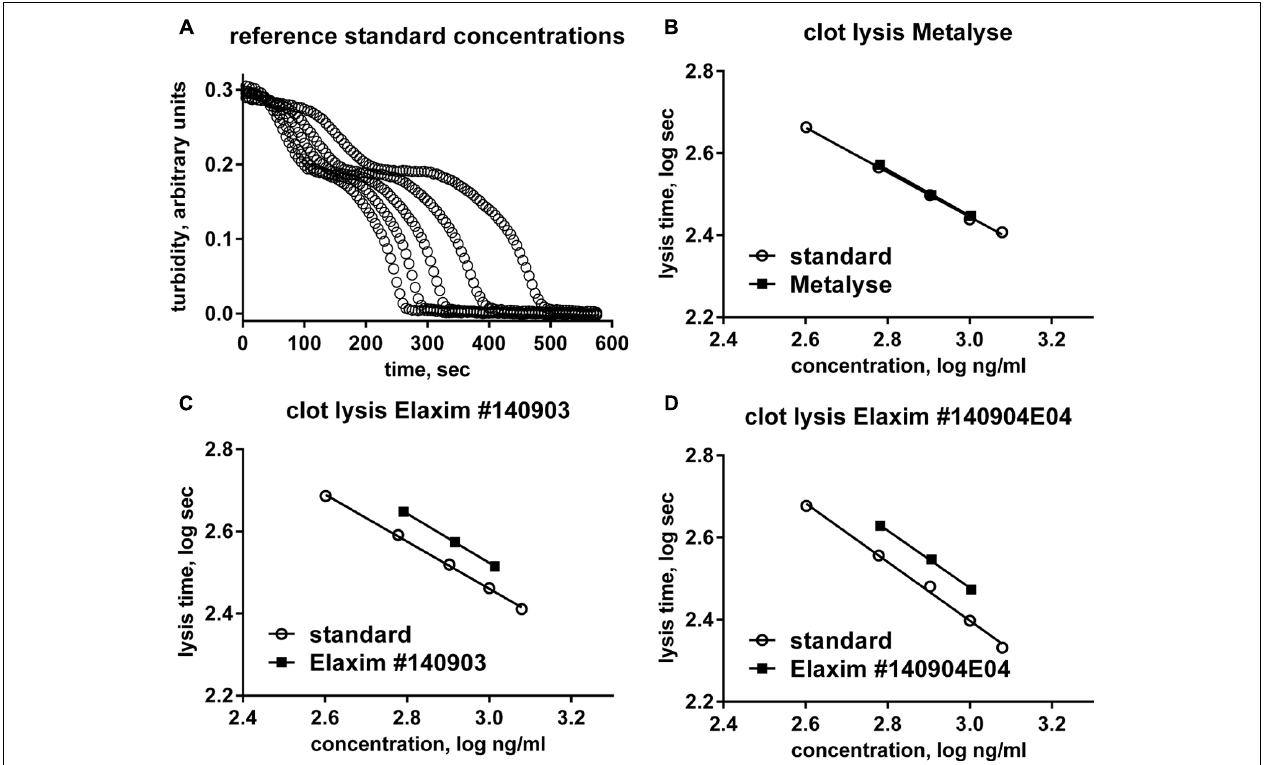
FIGURE 1 | In vitro clot lysis by one batch of Metalyse and two batches of Elaxim. (A) Raw data for the time course of turbidity change induced by 400, 600, 800, 1000, and 1200 ng/ml tenecteplase reference standard. (B–D) Double-logarithmic plot of clot lysis time vs. concentration